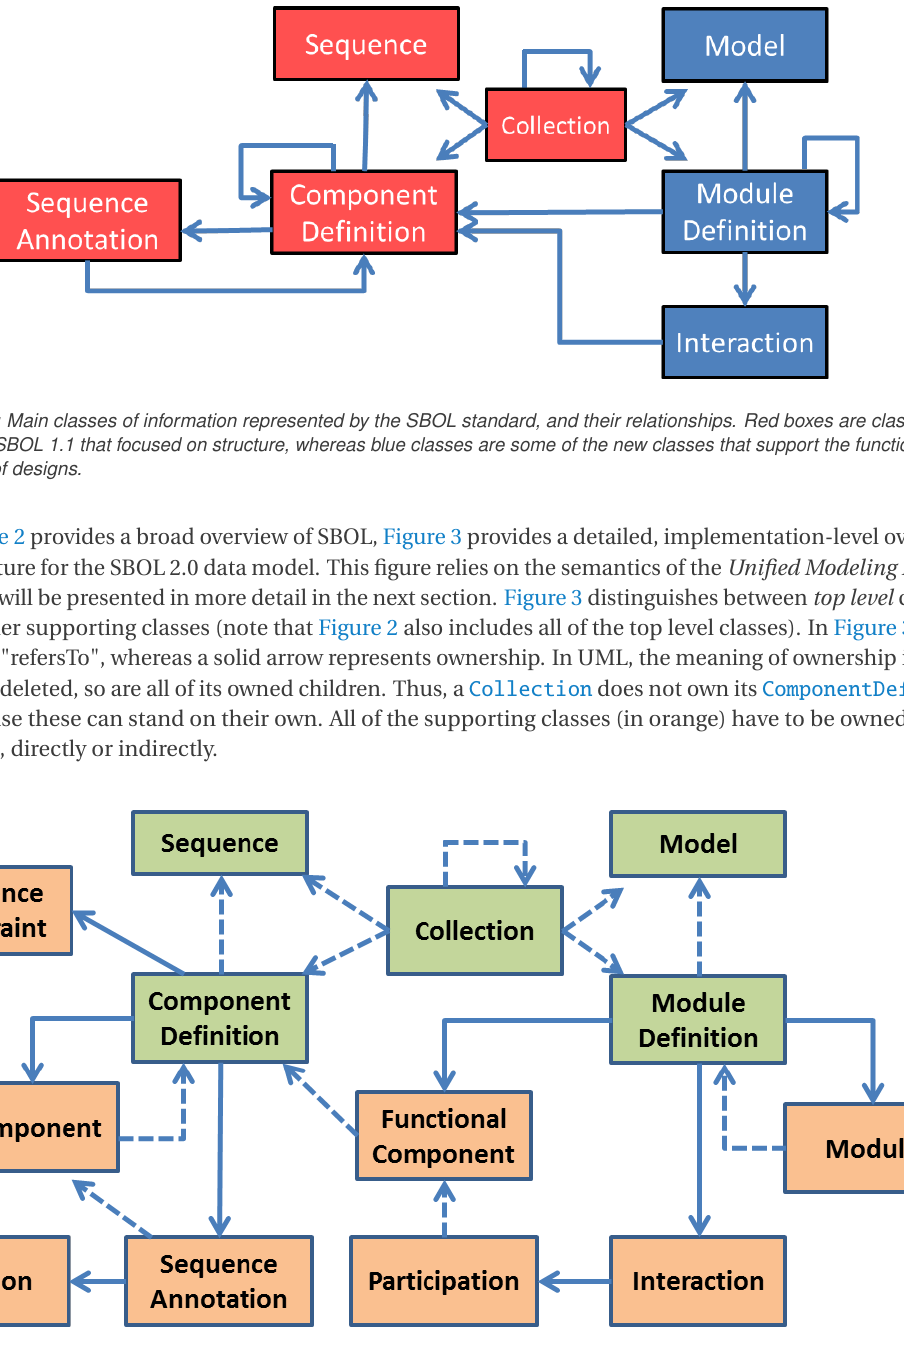
Figure 3: Main classes of information represented by the SBOL 2.0 standard, and their relationships. Green boxes are “top level” classes, while the other classes are in support of these classes. Solid arrows indicates ownership, whereas a dashed arrow indicates that one class refers to an object of another